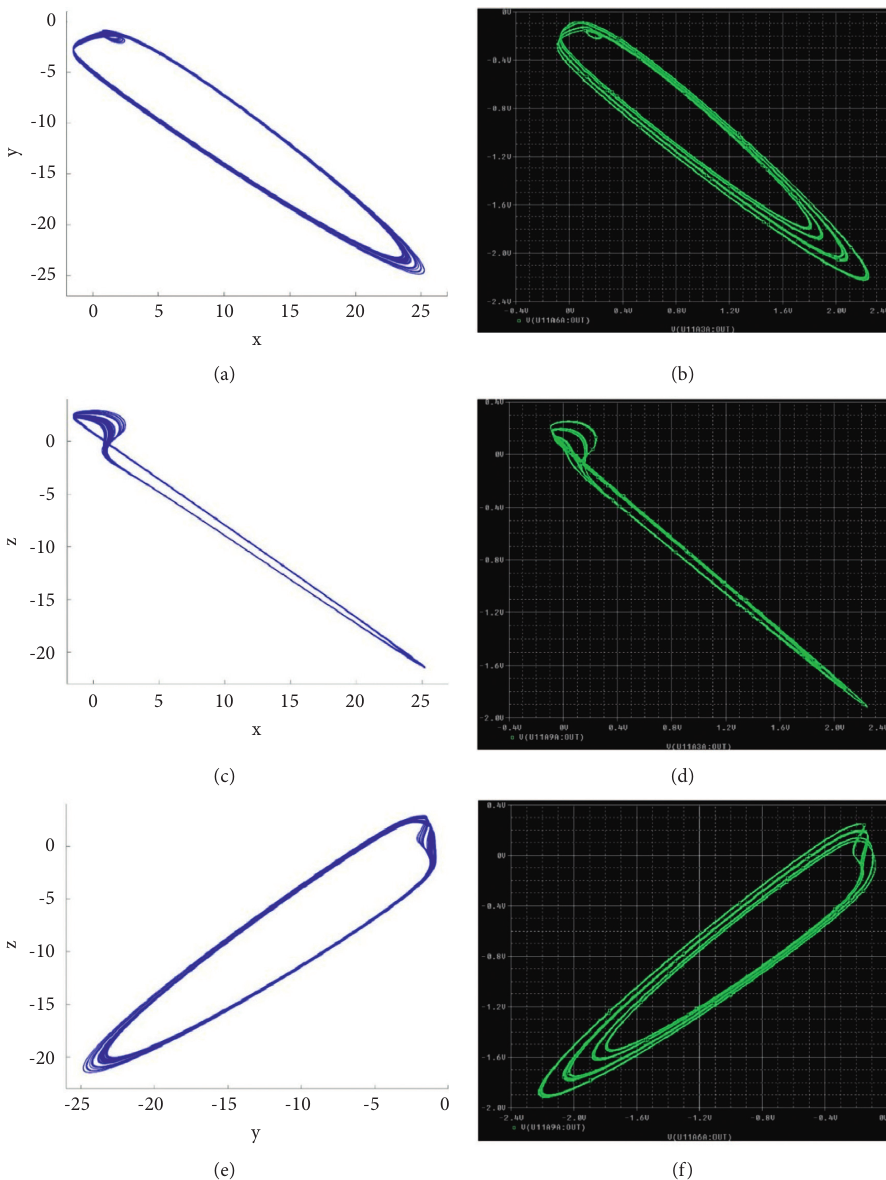
Figure 6: The results of Matlab and PSpice simulations for the system’s attractor when a � 0 . 5 and b � − 3 . 7. (a), (c), and (e) are related to the Matlab simulations when (b), (d), and (f) are generated by the analog circuit designed in PSpice. (a, b) The attractor’s projection in the XY plane, (c, d) the attractor’s shadow in the XZ plane, and (e, f) the attractor’s projection in the surface of the